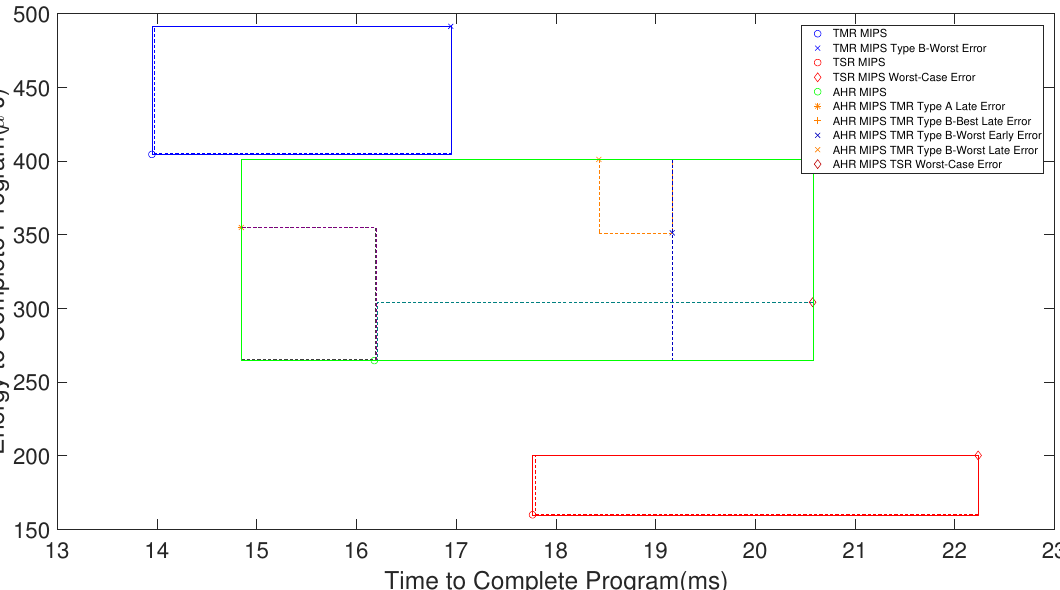
Figure 9. Average performance bounds for AHR MIPS with a TMR to TSR point at 20,000 instructions.